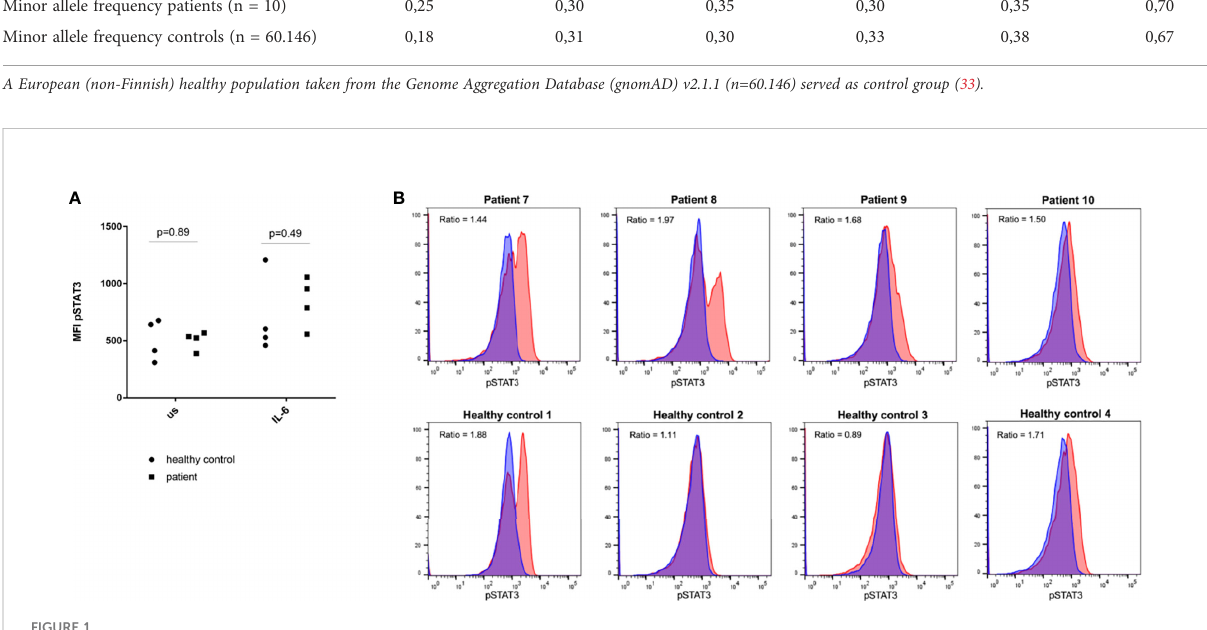
FIGURE 1 Phospho-speci fi c fl ow cytometry analysis of STAT3 in peripheral blood mononuclear cells of four patients with CSU aiTIIb and four healthy controls. (A) shows values of mean fl uorescent intensity (MFI) of phosphorylated STAT3 (pSTAT3) for patients compared to healthy controls in unstimulated cells (us) and after stimulation with interleukin-6 (IL-6). For statistical comparison a Mann-Whitney-U test was performed. (B) shows the amount of pSTAT3 before (blue) and after (red) stimulation with IL-6 for each individual in a histogram. The ratio of the MFI of pSTAT3 before and after stimulation is